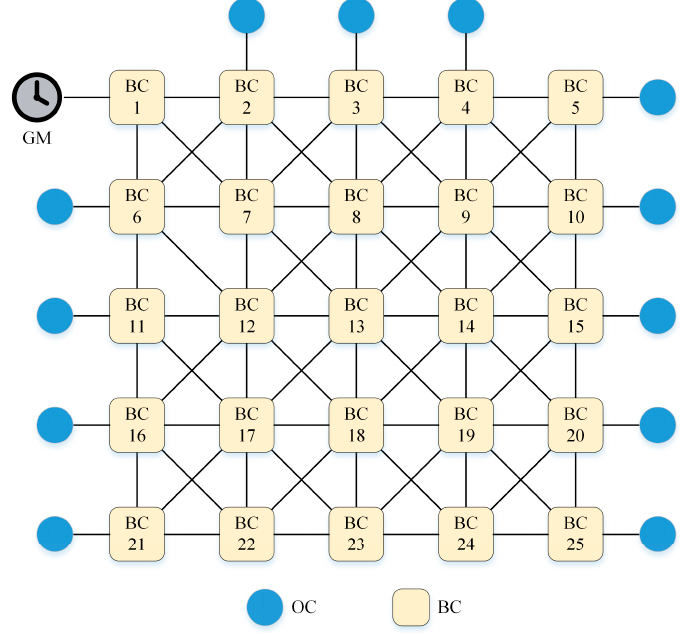
Figure 3. A sample PTP network with one GM clock and several OC and BCs.